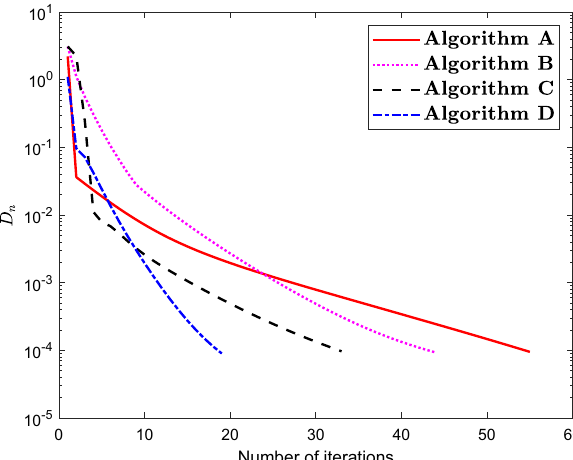
Fig. 1 Numerical illustration of Algorithm 1 with Algorithm 1 in [16] and Algorithm 3.1 in [1] and Algorithm 3.1 in [27] while m = 5